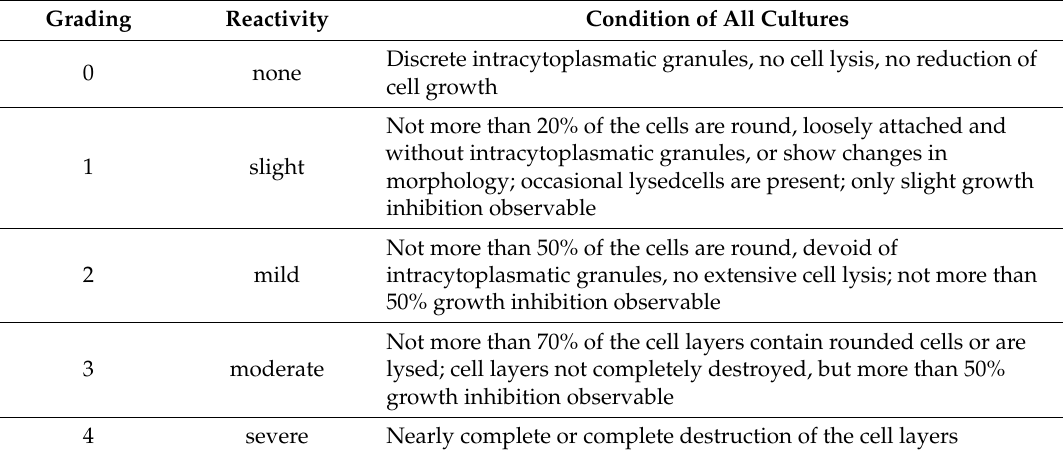
Table 2. Assessment of the reactivity index based on the ISO 10993-5